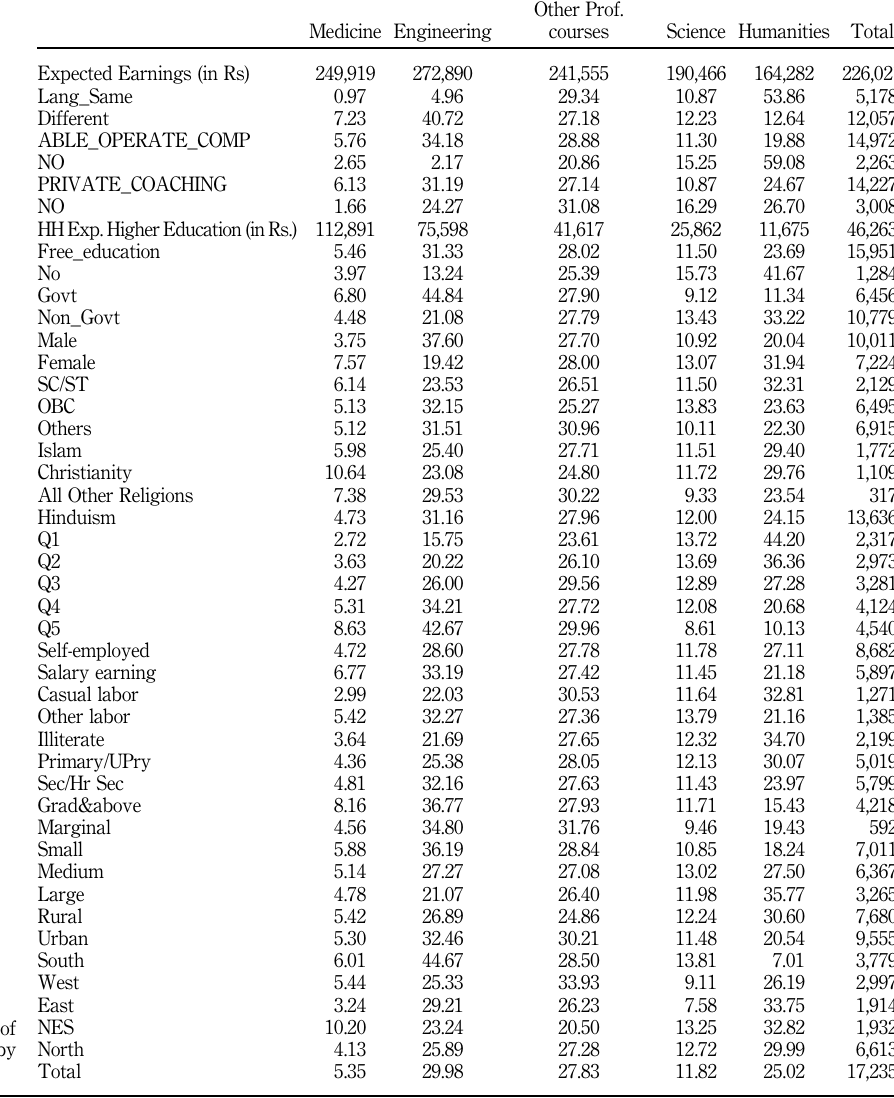
Table III. Summary statistics of attending students by major choice (in